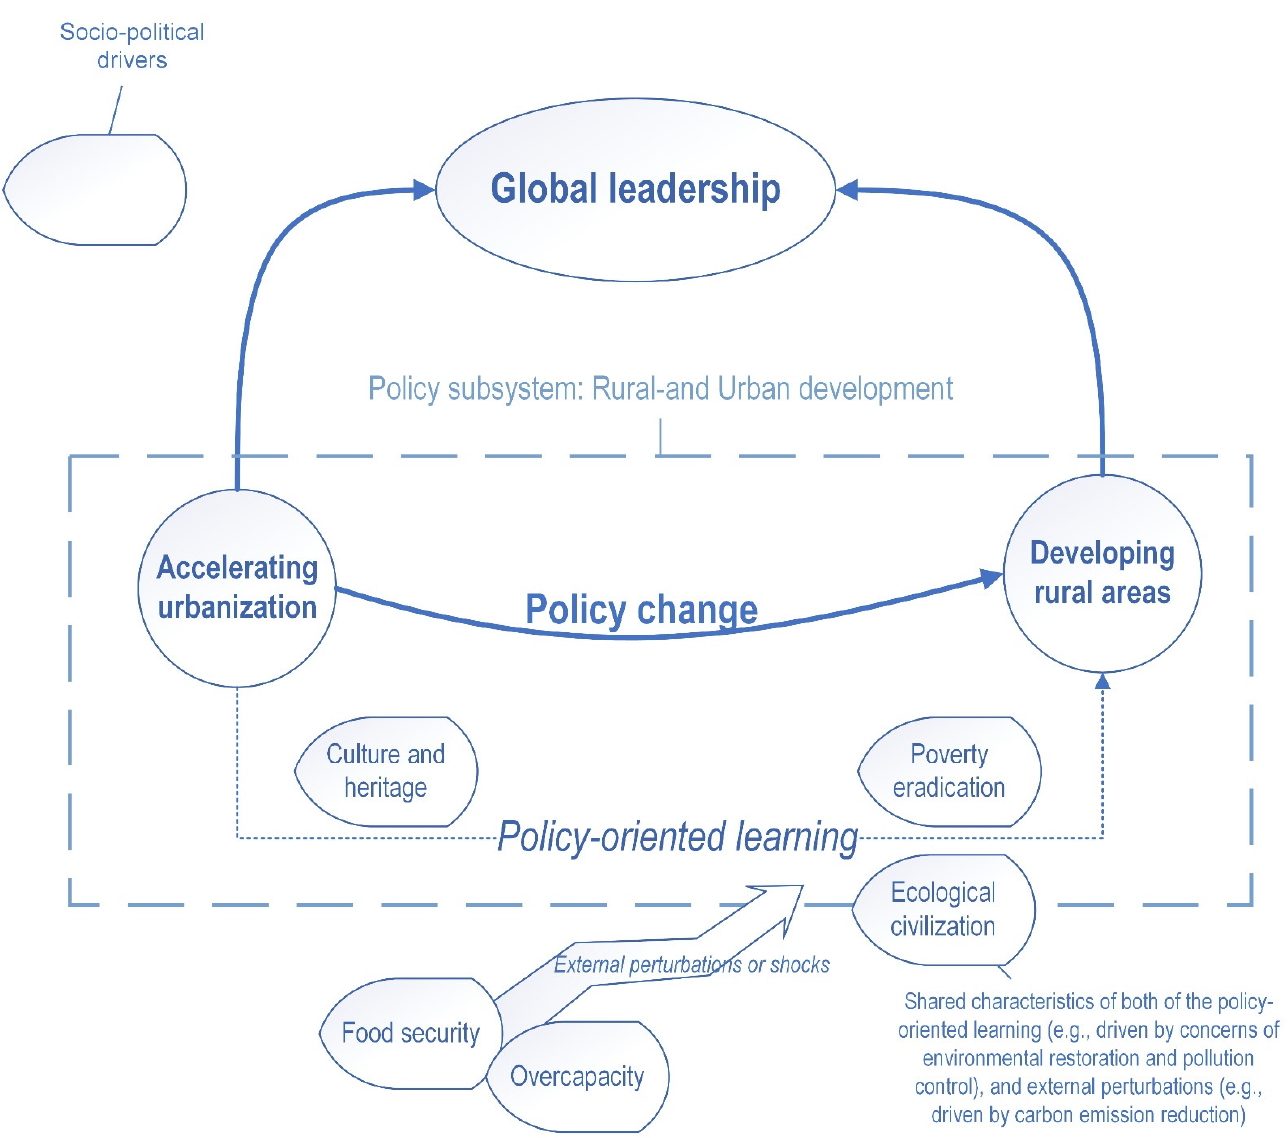
Figure 4. Policy change from accelerating urbanization to rural development and five socio-political drivers (Source: au- thors).